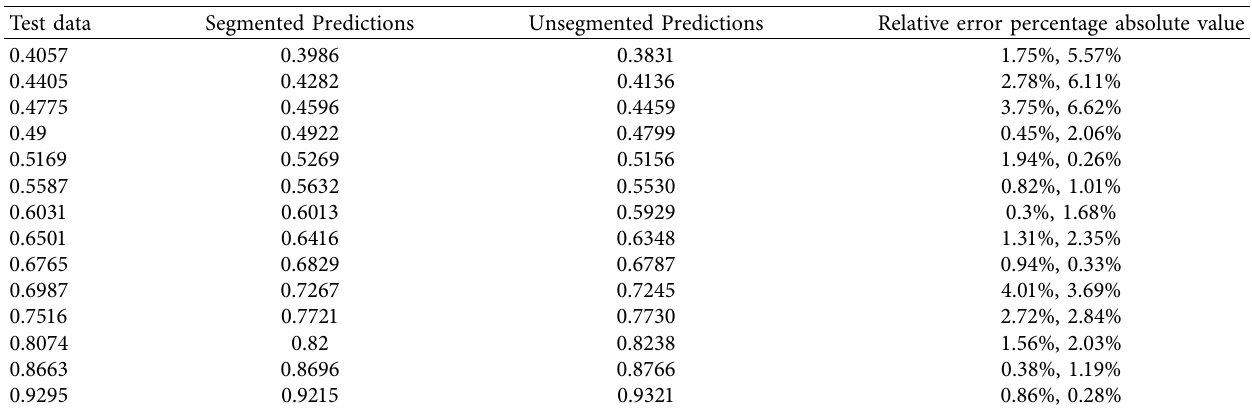
Table 3: Comparison of segmented prediction results with unsegmented prediction